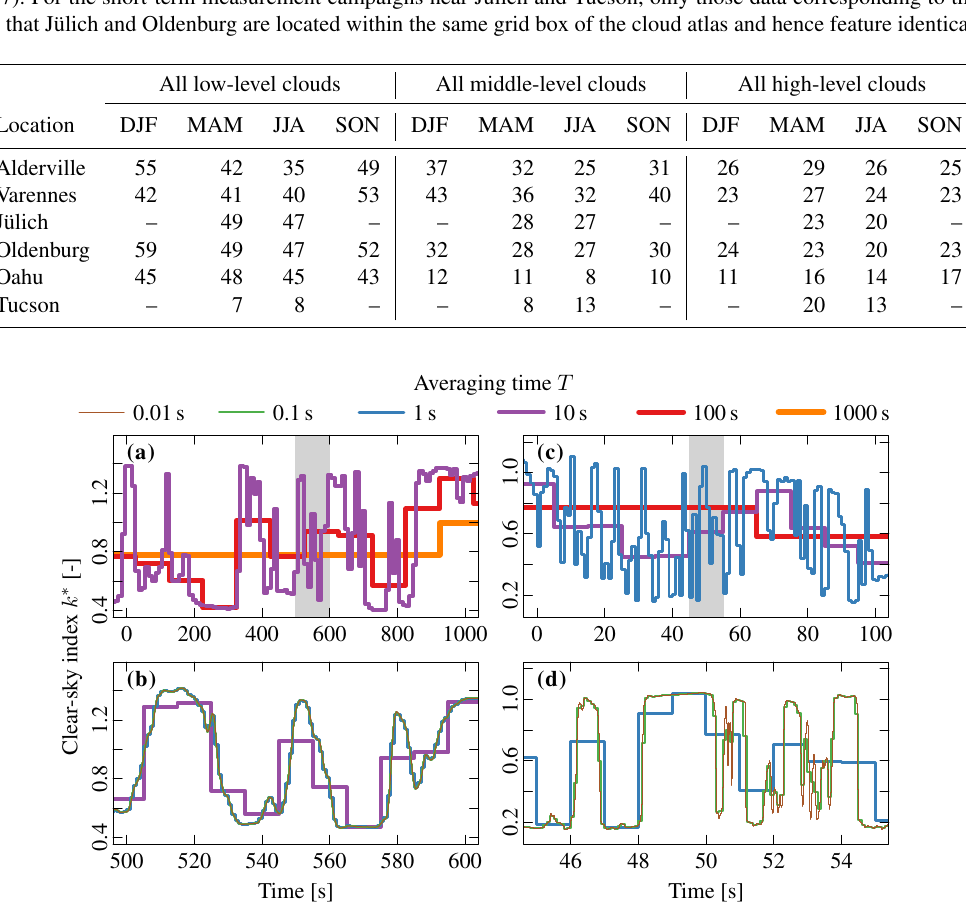
∗ time series under mixed sky conditions: panels Figure 1. Two representative examples of highly variable clear-sky index k (a) and (b) show a typical example of a 1000s period using six averaging times T , namely (a) T = 1000, T = 100, and T = 10s, and (b) T = 10, T = 1, T = 0 . 1, and T = 0 . 01s (note that throughout the analyses of the paper we restrict ourselves to values of T ≤ 900s; we consider up to T = 1000s here for illustrative purposes); panels (c) and (d) show an unusual 100s example with evident variability down to the shortest time scales with averaging periods (a) T = 100, T = 10, and T = 1s, and (b) T = 1, T = 0 . 1, and T = 0 . 01s. The time series were measured in Varennes on 2 March 2016, starting at 15:01:35EDT (a, b) , and on 21 September 2016, starting at 15:06:35EDT (c, d) . The gray areas in the top row indicate the excerpts presented in the bottom